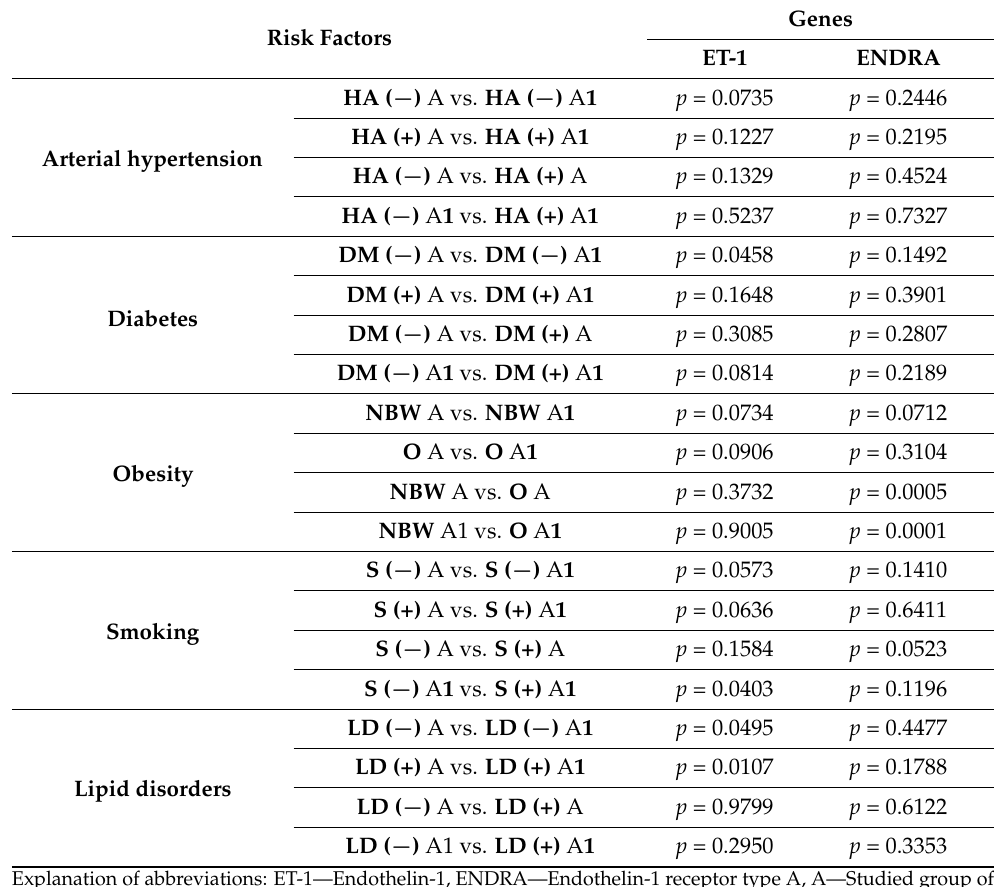
Table 10. Transcriptional activity of the studied genes among patients after myocardial infarction before (A) and after early post-hospital cardiac rehabilitation (A1) taking into account the factors